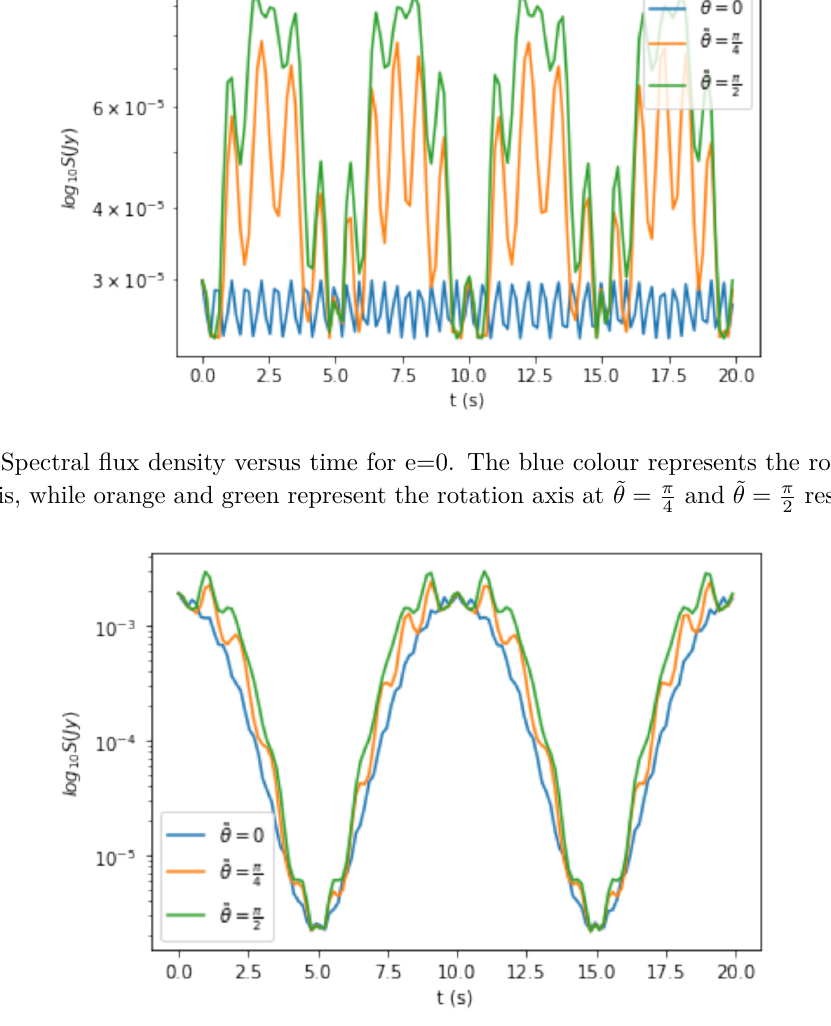
Figure 4 . Spectral flux density versus time for e=0.5. The blue color represents the rotation axis on the z axis, while orange and green represent the rotation axis at ˜ θ = π